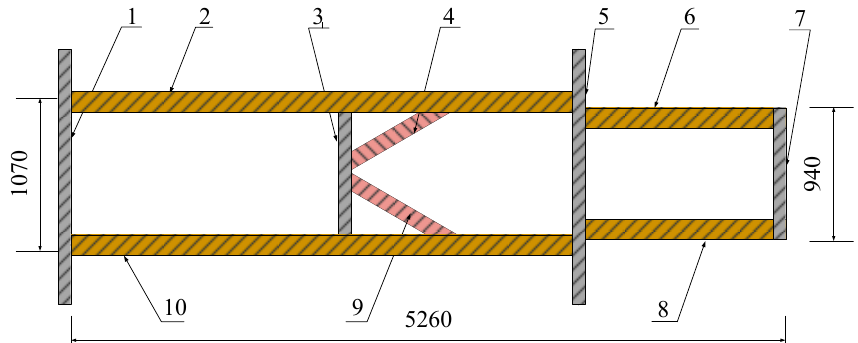
Figure 3. General scheme of frame structure.